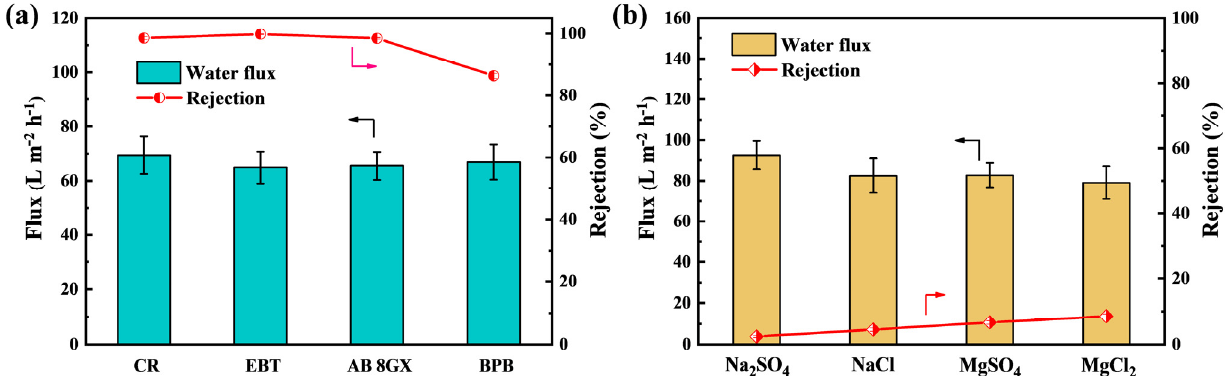
Figure 6. Separation performance of PES/Fe-TA-PEI membranes for different dye ( a ) and salt ( b ) solutions.